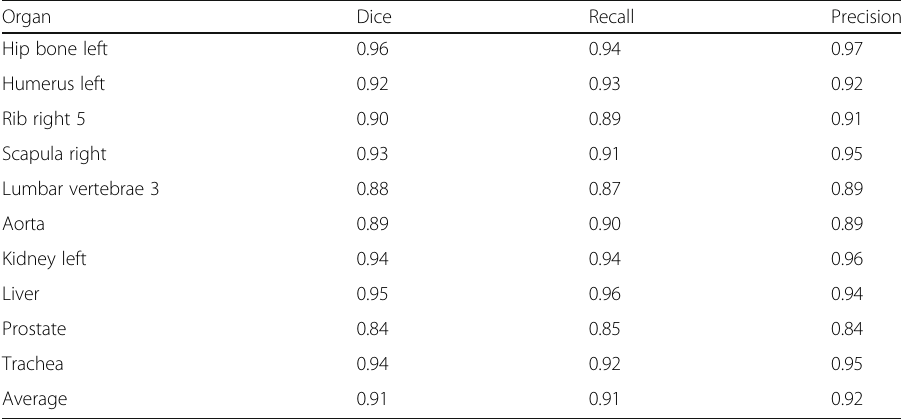
Table 4 Inter-observer Dice index, recall, and precision for the two readers, per organ on an independent test set of 10 patients (5 male/5 female) Organ Dice Recall Precision Hip bone left